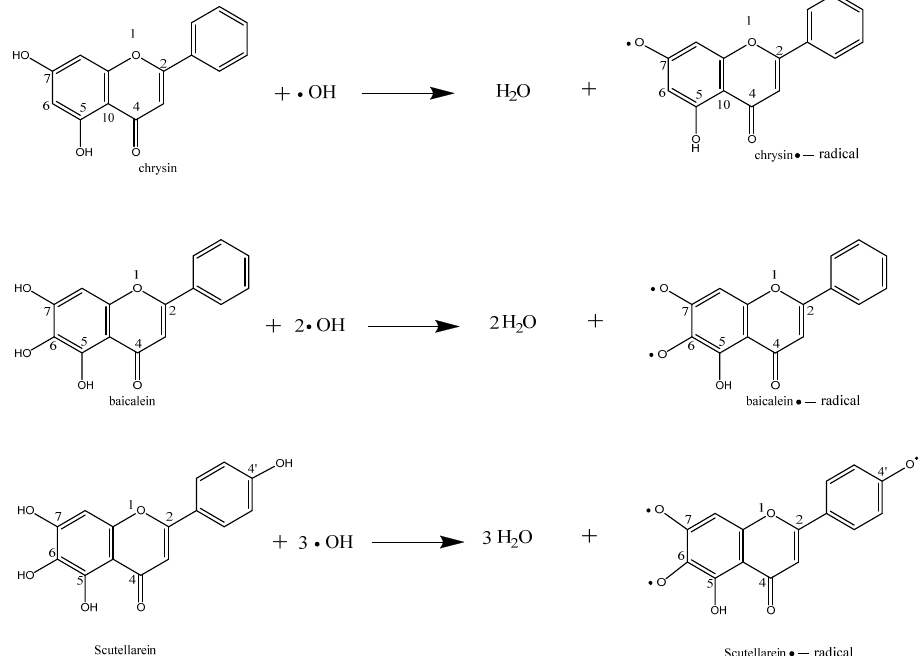
Figure 9. Reaction mechanism between free radicals and active molecular phenolic hydroxyl groups and possible molecular structure of active molecular radical.